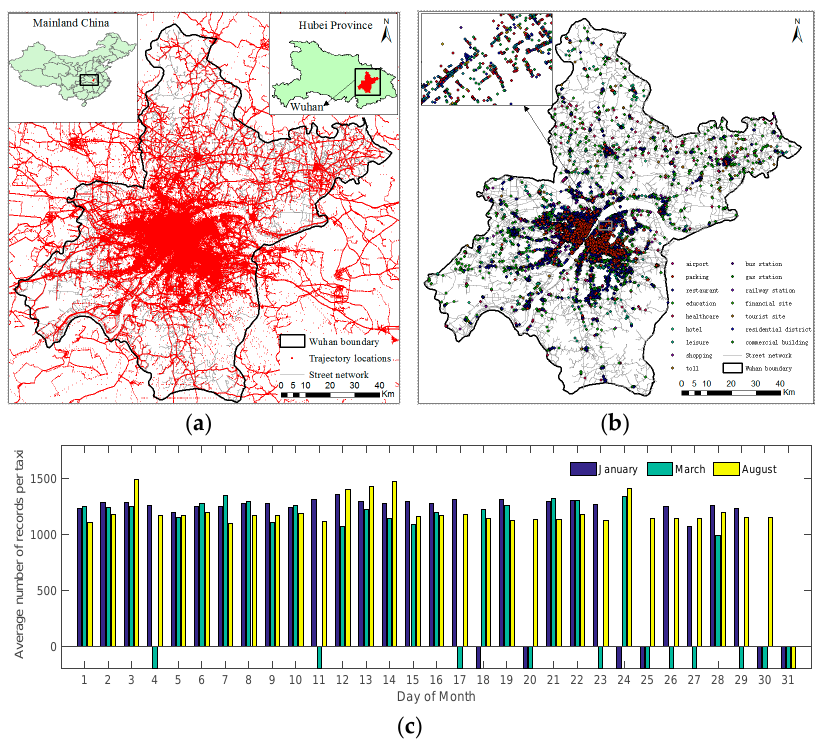
Figure 1. Datasets used in this study: ( a ) trajectories in March overlaid on the urban street network; ( b ) Points of Interest (POI) dataset overlaid on the urban street network; ( c ) average number of records per taxi during each day in January, March, and August, where x -axis is the day of month, y -axis labels the average number of records per taxi, and the day with negative number implies the absence of records.